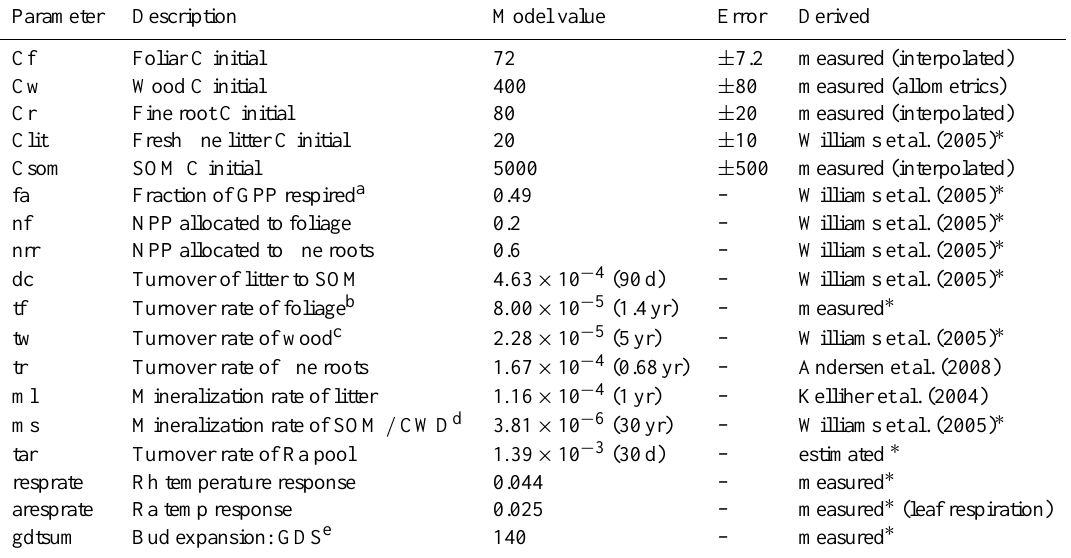
Table 2. Key parameter values for the carbon allocation–respiration part of the soil–plant–atmosphere model. Biomass C is given in gm − 2